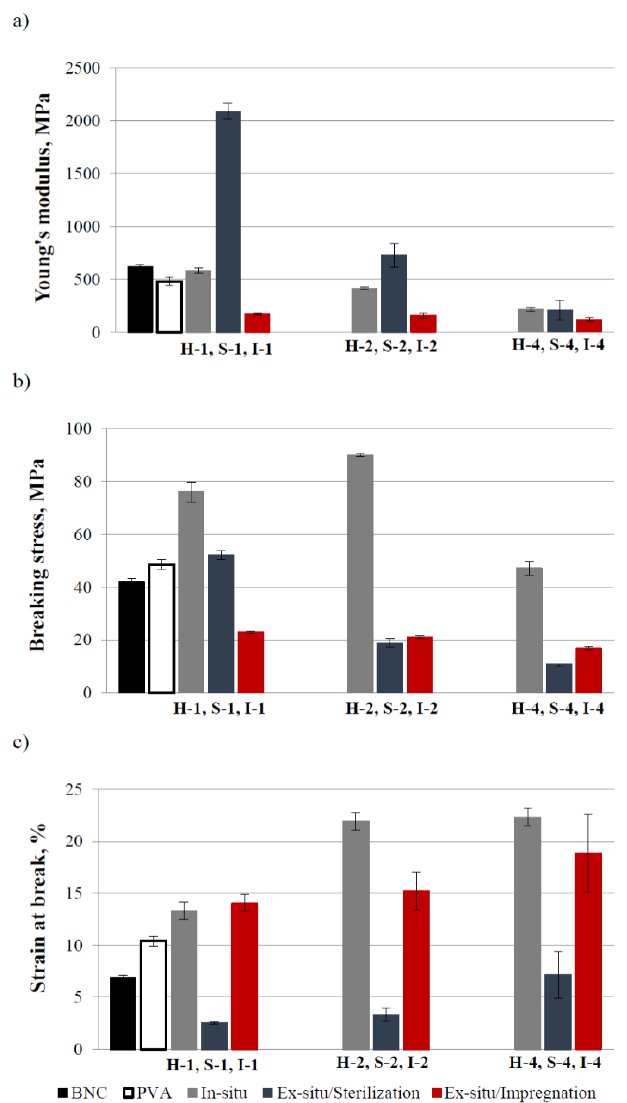
Figure 8. Mechanical properties of wet samples of BNC, PVA, and BNC/PVA composites obtained by different methods: Young’s modulus ( a ), breaking stress ( b ), and strain at break ( c ).